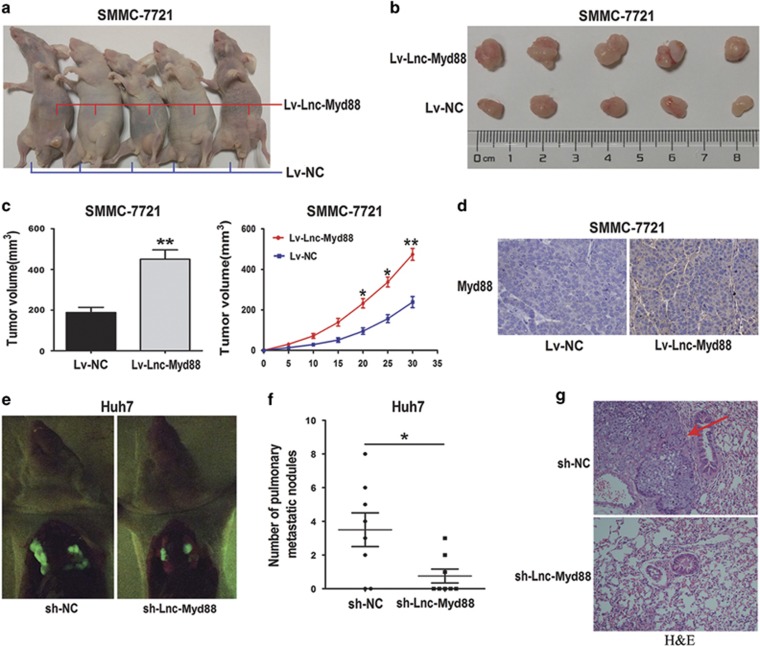
Lnc-Myd88 enhances tumor growth and metastasis in vivo. (a–c) BAB/c nude mice (6 weeks of age) were subcutaneous transplantated with SMMC-7721 cells, Lv-Lnc-Myd88-SMMC-7721 cells (1 × 107) in the right groin and Lv-NC SMMC-7721 (1 × 107) cells in the left groin (5 mice in each group). The volume of tumors was calculated every 5 days after transplantation and mice were killed 30 days after implantation. Lnc-Myd88 strengthen the tumor growth of SMMC-7721 cells in nude mice. The volume of each tumor was calculated as the length × width2 × 0.5. (d) Myd88 expression level in the tumor samples determined by IHC. Original magnification × 200. (e) In the tail vein xenograft model, mice (8 in each group) were injected with Huh7 cells (1 × 107 suspended in 200 μl PBS) through the tail vein and killed 5 weeks later, lung metastasis were investigated in each group respectively by an in vivo fluorescence imaging system. (f) Compared with the Lnc-Myd88 knockdown group (three mice presented lung colonization), six mice presented lung colonization with more and larger tumors in the control group. (g) All the results of lung colonization were validated by the histological examination (H&E). Original magnification × 200 (*P<0.05, **P<0.01)